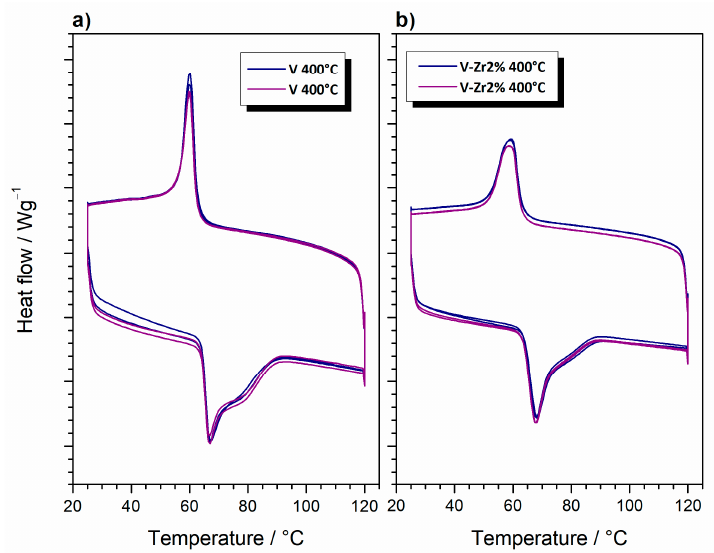
Figure 14. DSC curves of VO 2 prepared from samples ( a ) pure V and ( b ) V-Zr2%, by thermal treatment at 400 ◦ C for 5 min; bottom curves—heating, upper curves—cooling.